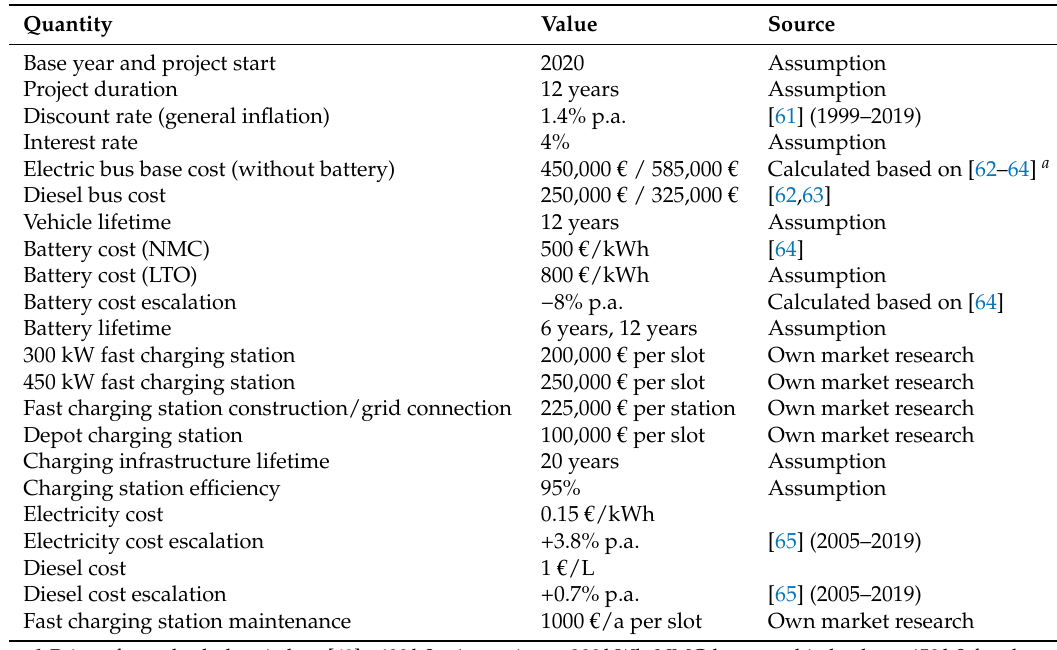
Table 8. TCO parameters. Values of the form X/Y denote standard and articulated buses, respectively. Quantity